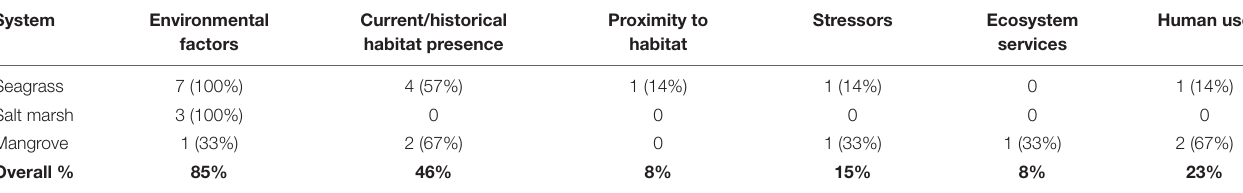
TABLE 4 | Number (and percent) of papers using different types of parameters for site selection.